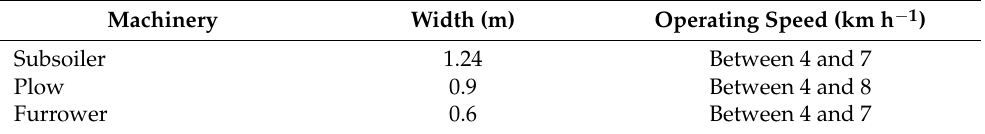
Table 4. Data for CM calculation.